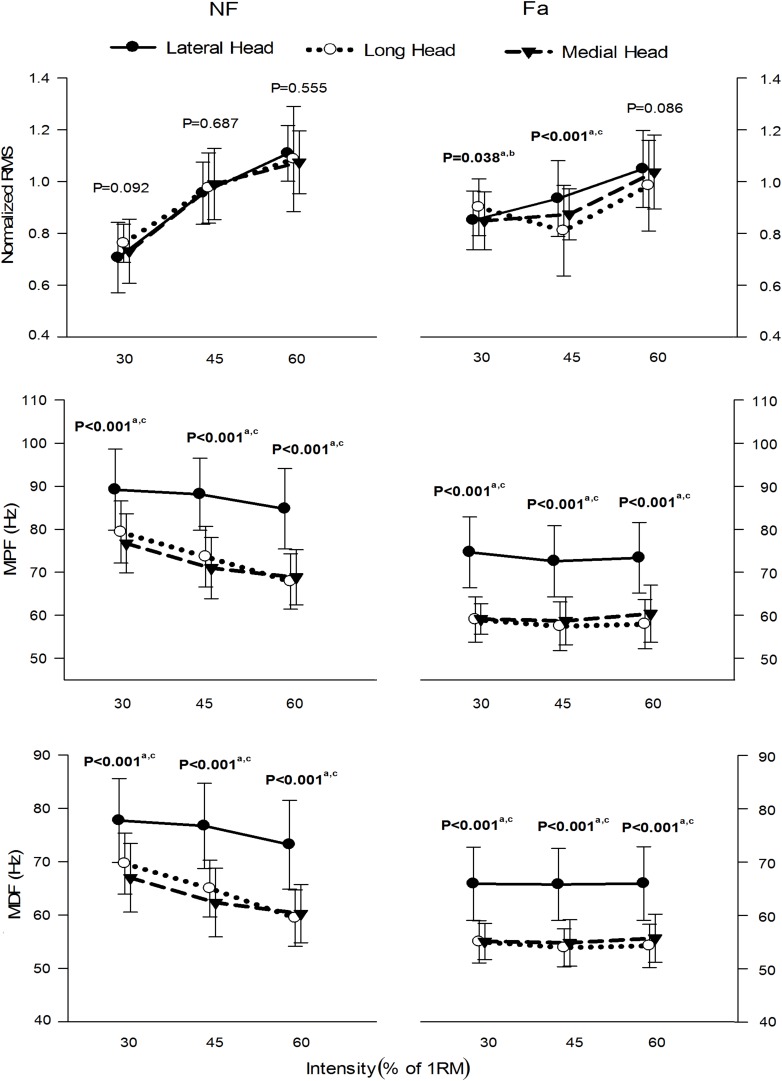
μ(SD) of the normalized RMS, MPF, and MDF of the three heads of the TB at 30, 45, and 60% 1RM under NF and Fa conditions. Bold font indicates statistical significance (a – lateral and long, b – long and medial, c – lateral and medial).